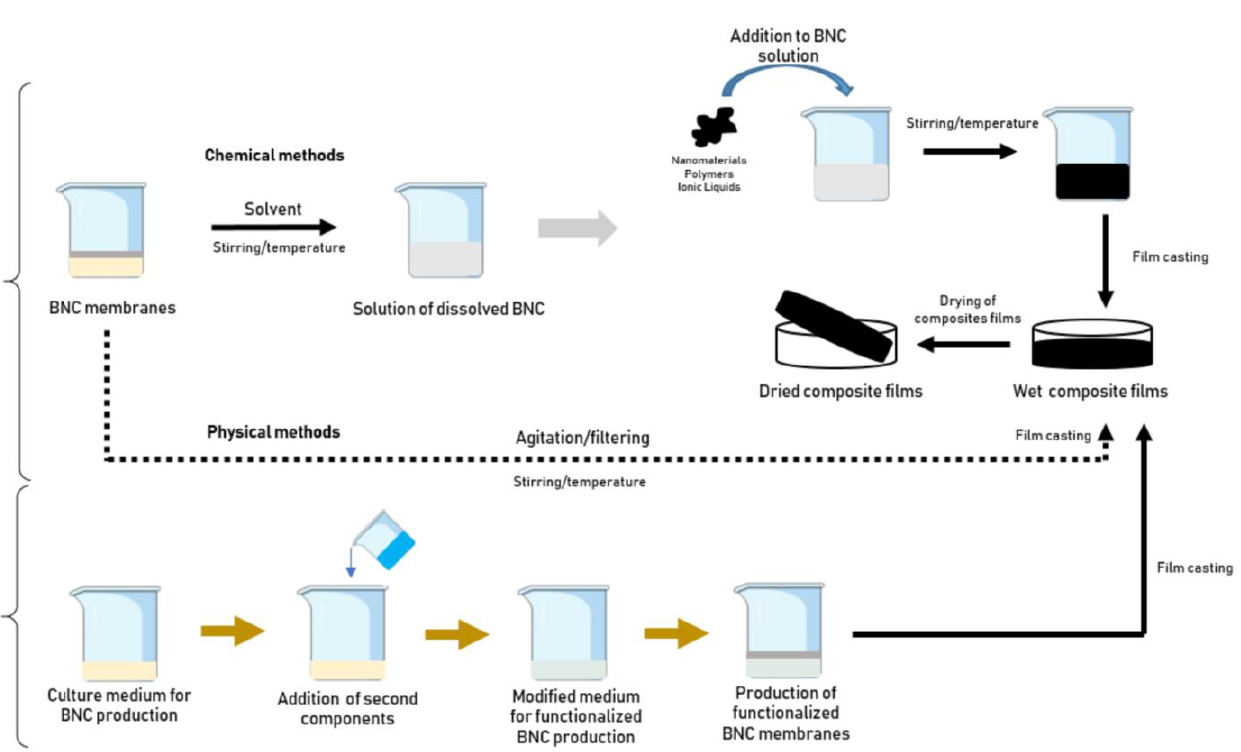
Figure 3. Schematic representation of BNC composites synthesized through in situ synthetic and ex situ modification strategies. The example illustrates the penetration of particles in the BNC matrix through chemical, physical, and in situ methods.